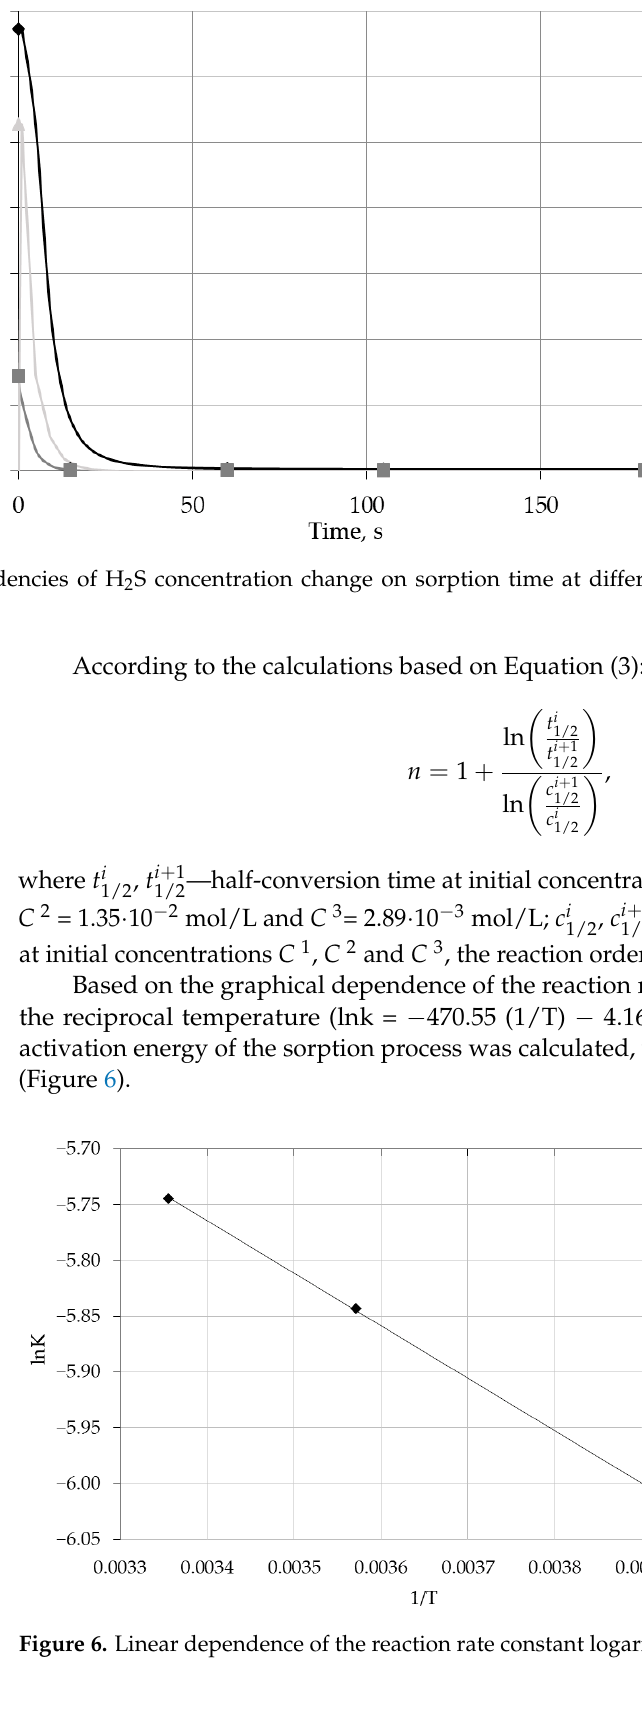
Figure 6. Linear dependence of the reaction rate constant logarithm on the reciprocal temperature.